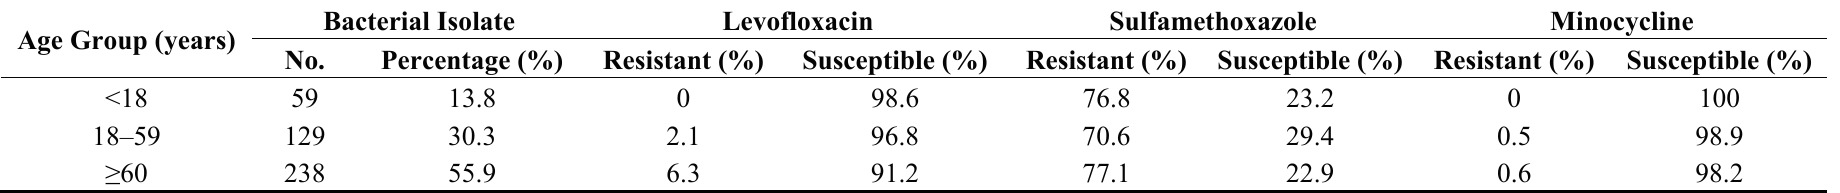
Emergency Neurology Others Table 4. Resistance of Stenotrophomonas maltophilia to three fluoroquinolone antibacterial drugs among patients at 3 age groups. Age Group